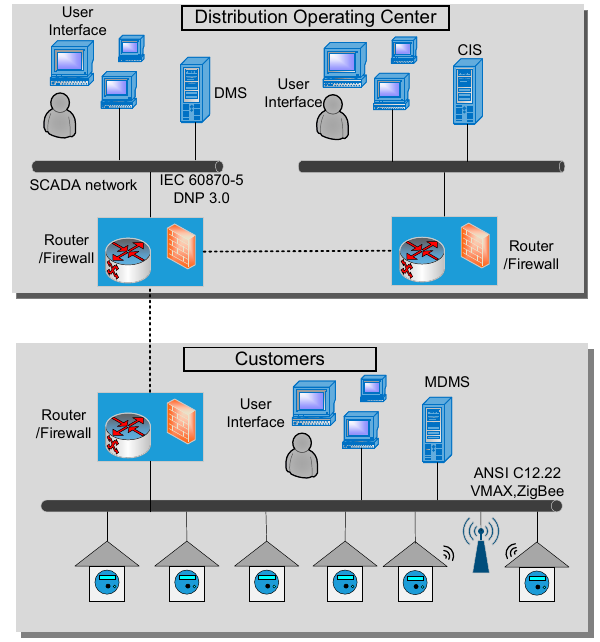
Figure 2. The architecture for integration of smart meters in the distribution operating center.